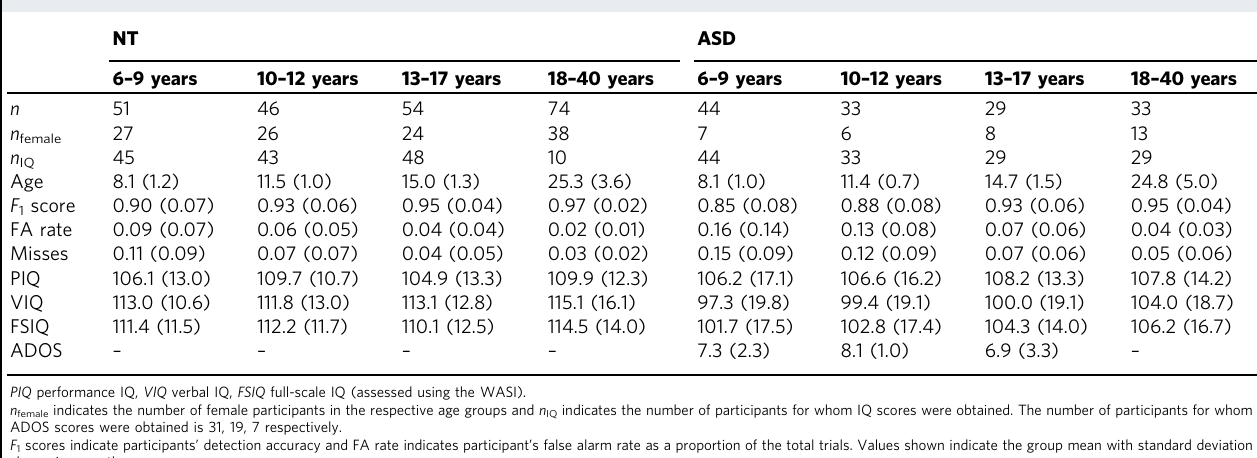
Table 1 Demographic characteristics of participant populations.